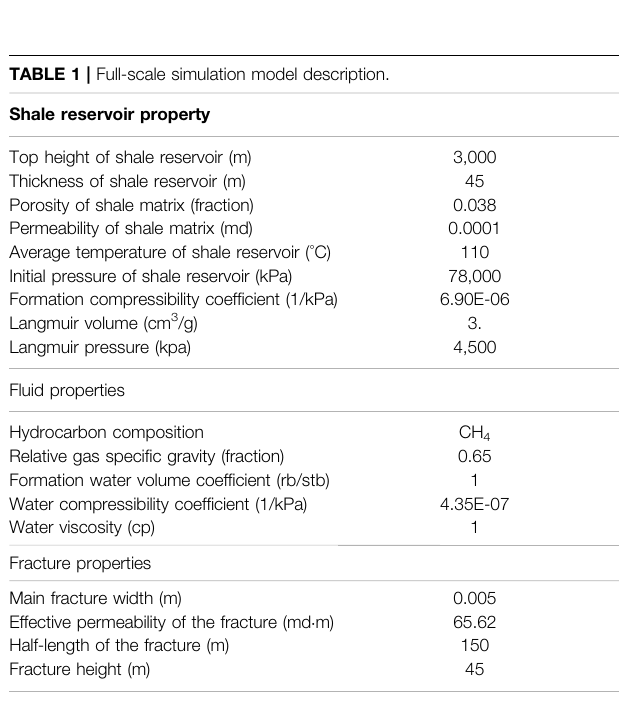
FIGURE 5 | Diagram of the shale gas reservoir mechanism model.